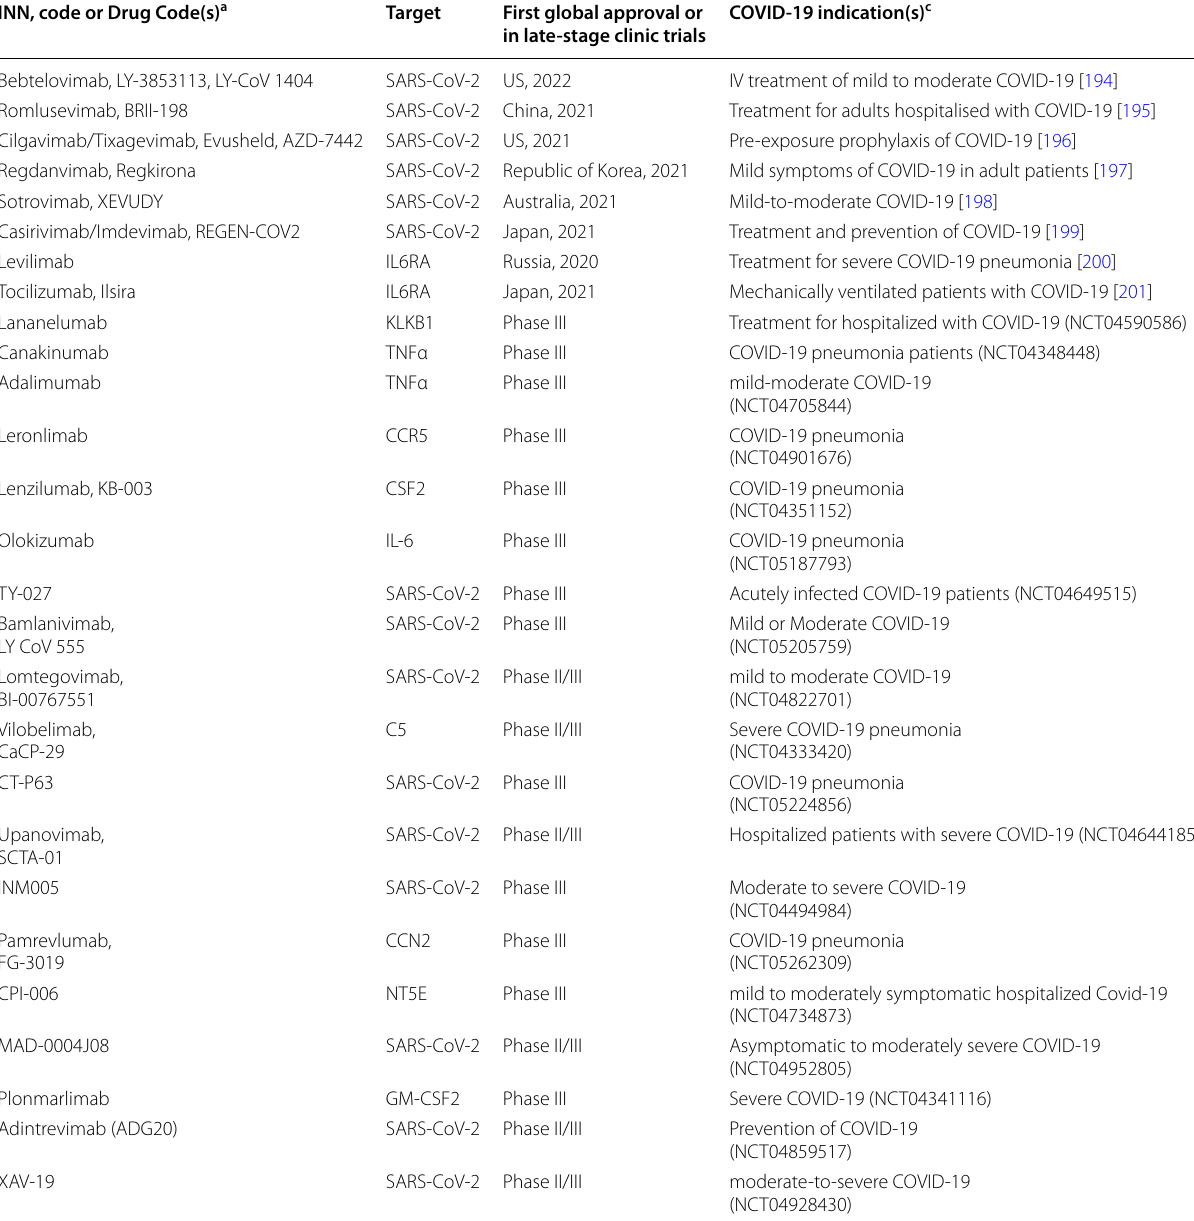
Table 4 MAbs first approved or in late-stage clinical trials for COVID-19 b